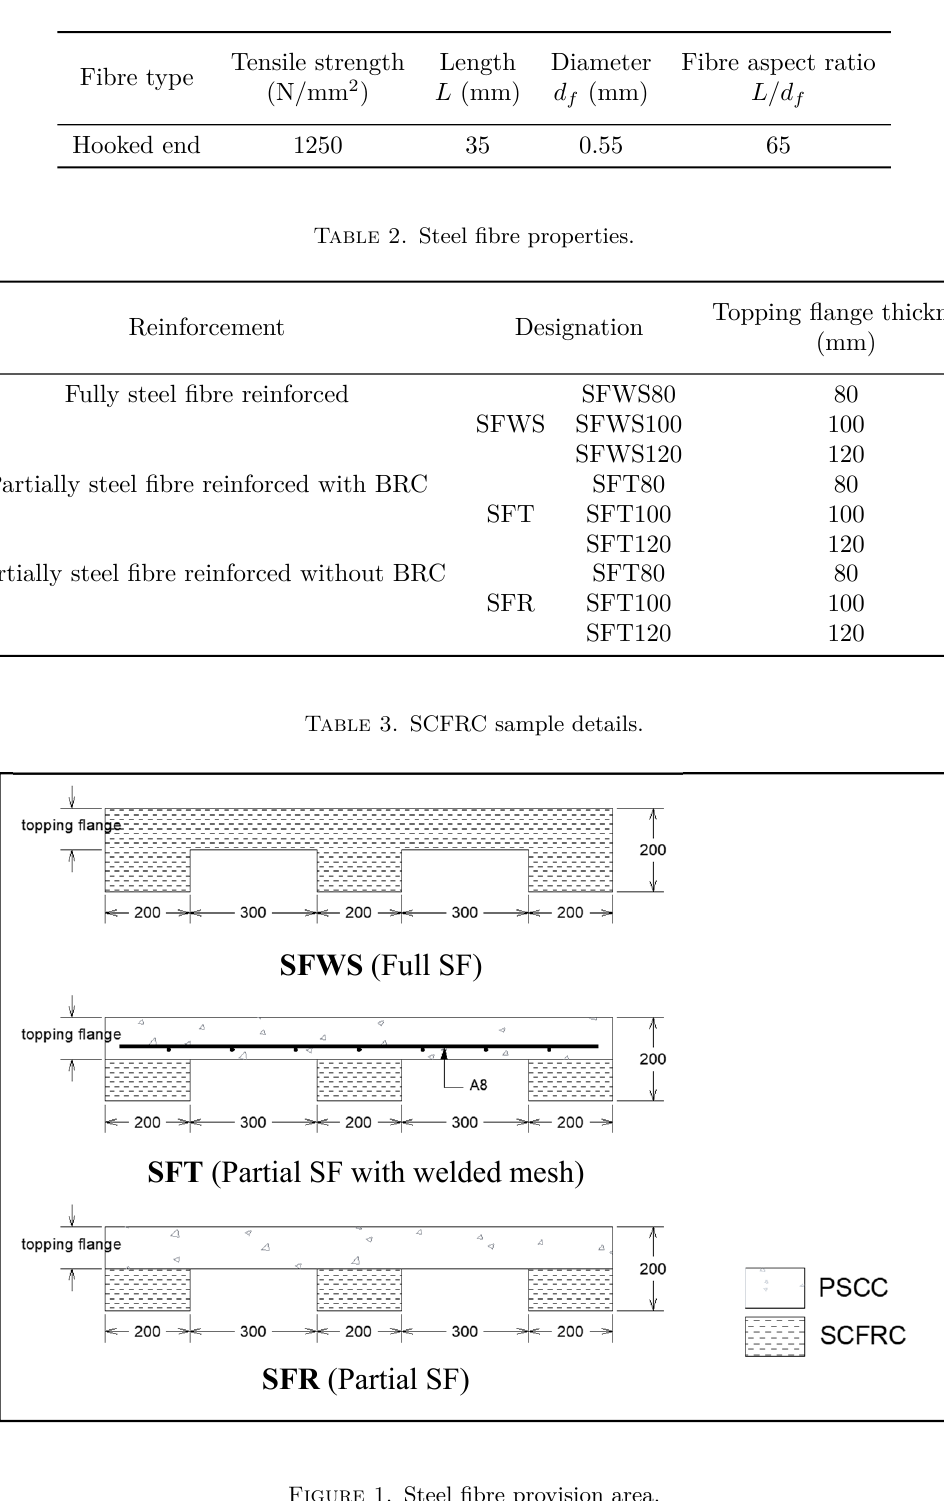
Table 1. SCC mix composition.